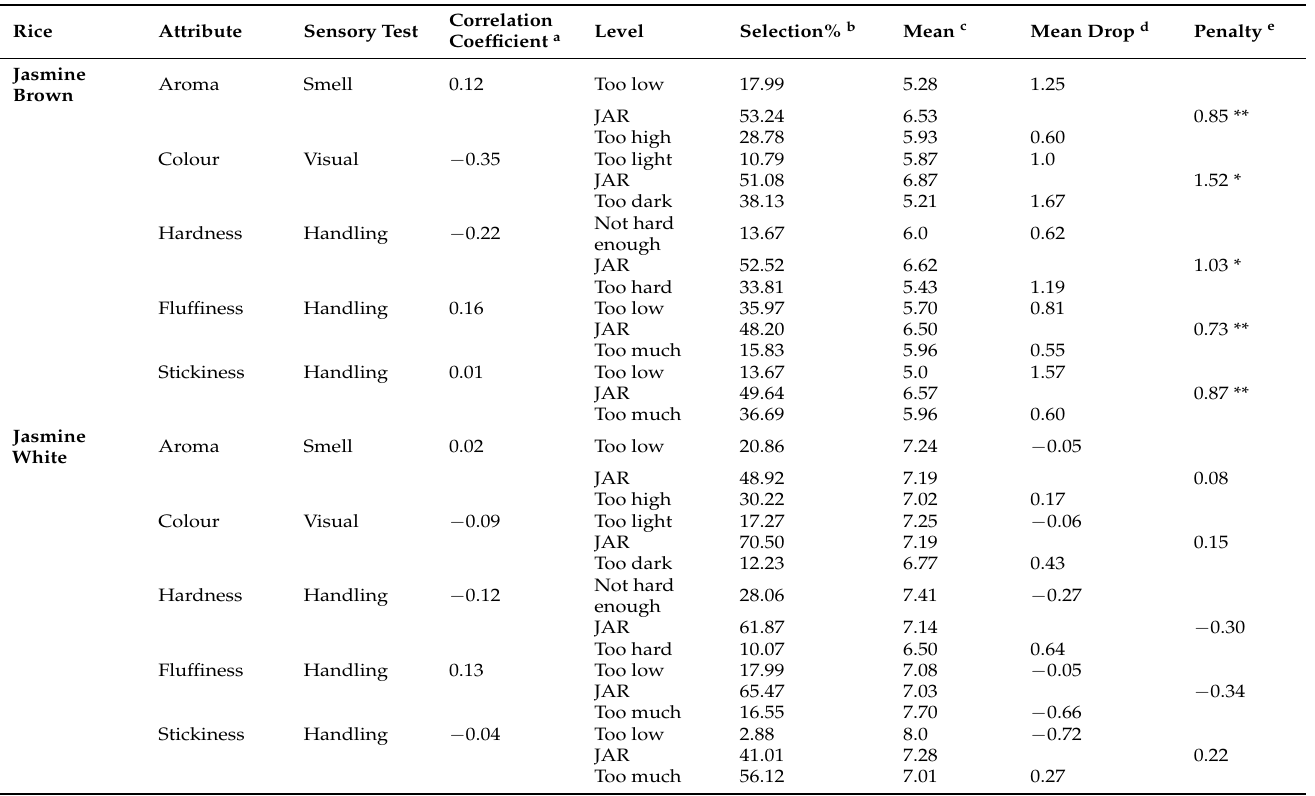
Table 5. The Penalty analysis and JAR variables (before tasting) for Jasmine brown and white